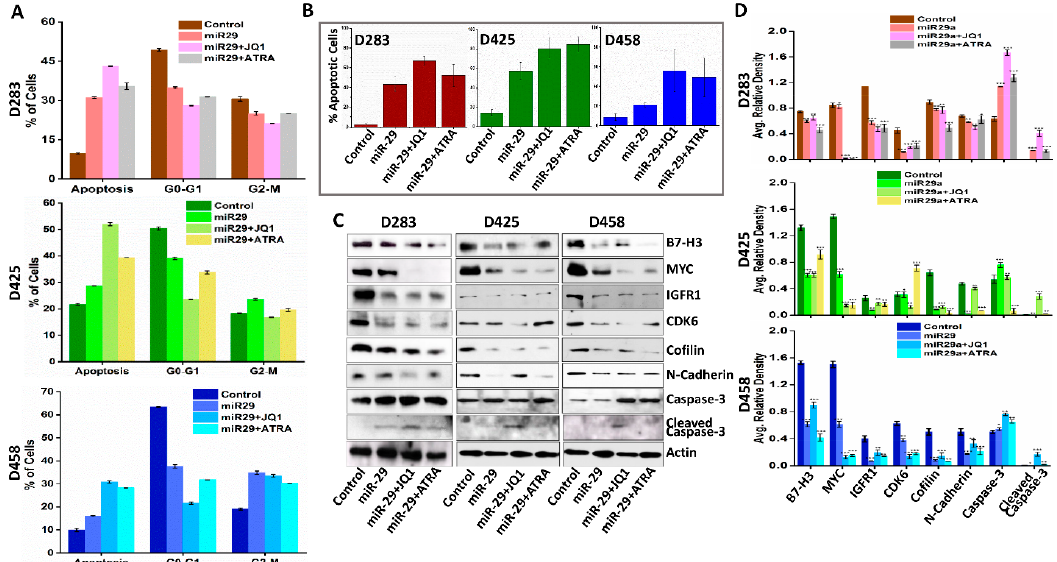
Figure 6. Therapeutic option of combining miR-29 with JQ1 or ATRA in MB. ( A ) FACS analysis of cell cycle progression in D283, D425 and D458 cells 48 h after miR-29 alone and in combination with JQ1 and ATRA treatment. The y axis denotes percentage of total cell count and the x axis represents DNA content. The percentage of cells in the G1 (M2), S (M3) and G2 / M (M4) phases of the cell cycle were calculated using CellQuest Pro software. ( B ) Graphs from TUNEL staining assay showing increased apoptosis of combination treatments in D283, D425 and D458 cells ( n = 3 for each group). Significance calculated compared to control. ( C ) Western blot analysis of whole cell lysates from D283, D425 and D458 control, miR-29, miR-29 + JQ1, and miR-29 + ATRA cells to determine the expression of molecules associated with cell cycle, apoptosis, and EMT. Actin was used as a loading control. ( D ) Bar graphs from densitometry analysis of Western blots. Band intensity was normalized to each actin band for each sample. * p < 0.05, ** p < 0.01, *** p < 0.001.